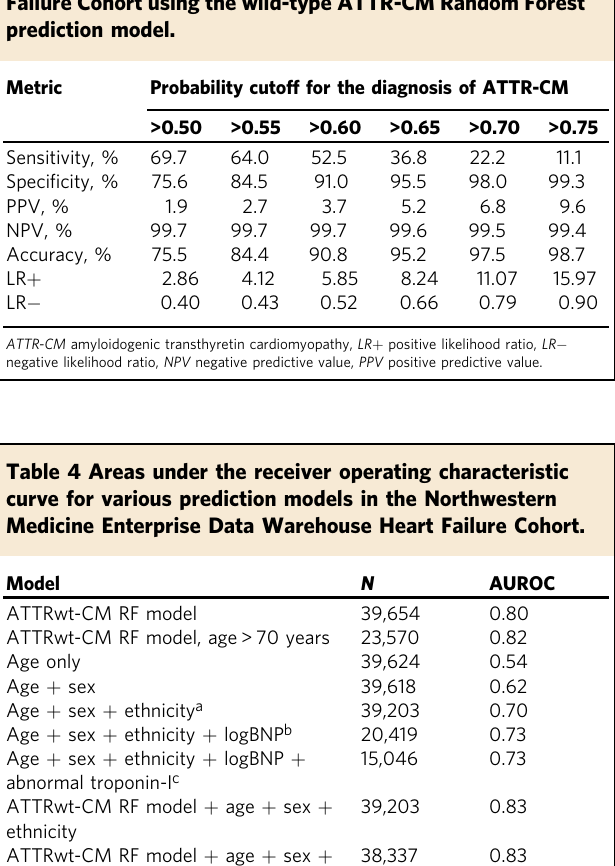
borating fi ndings on these routine clinical tests obtained in all HF